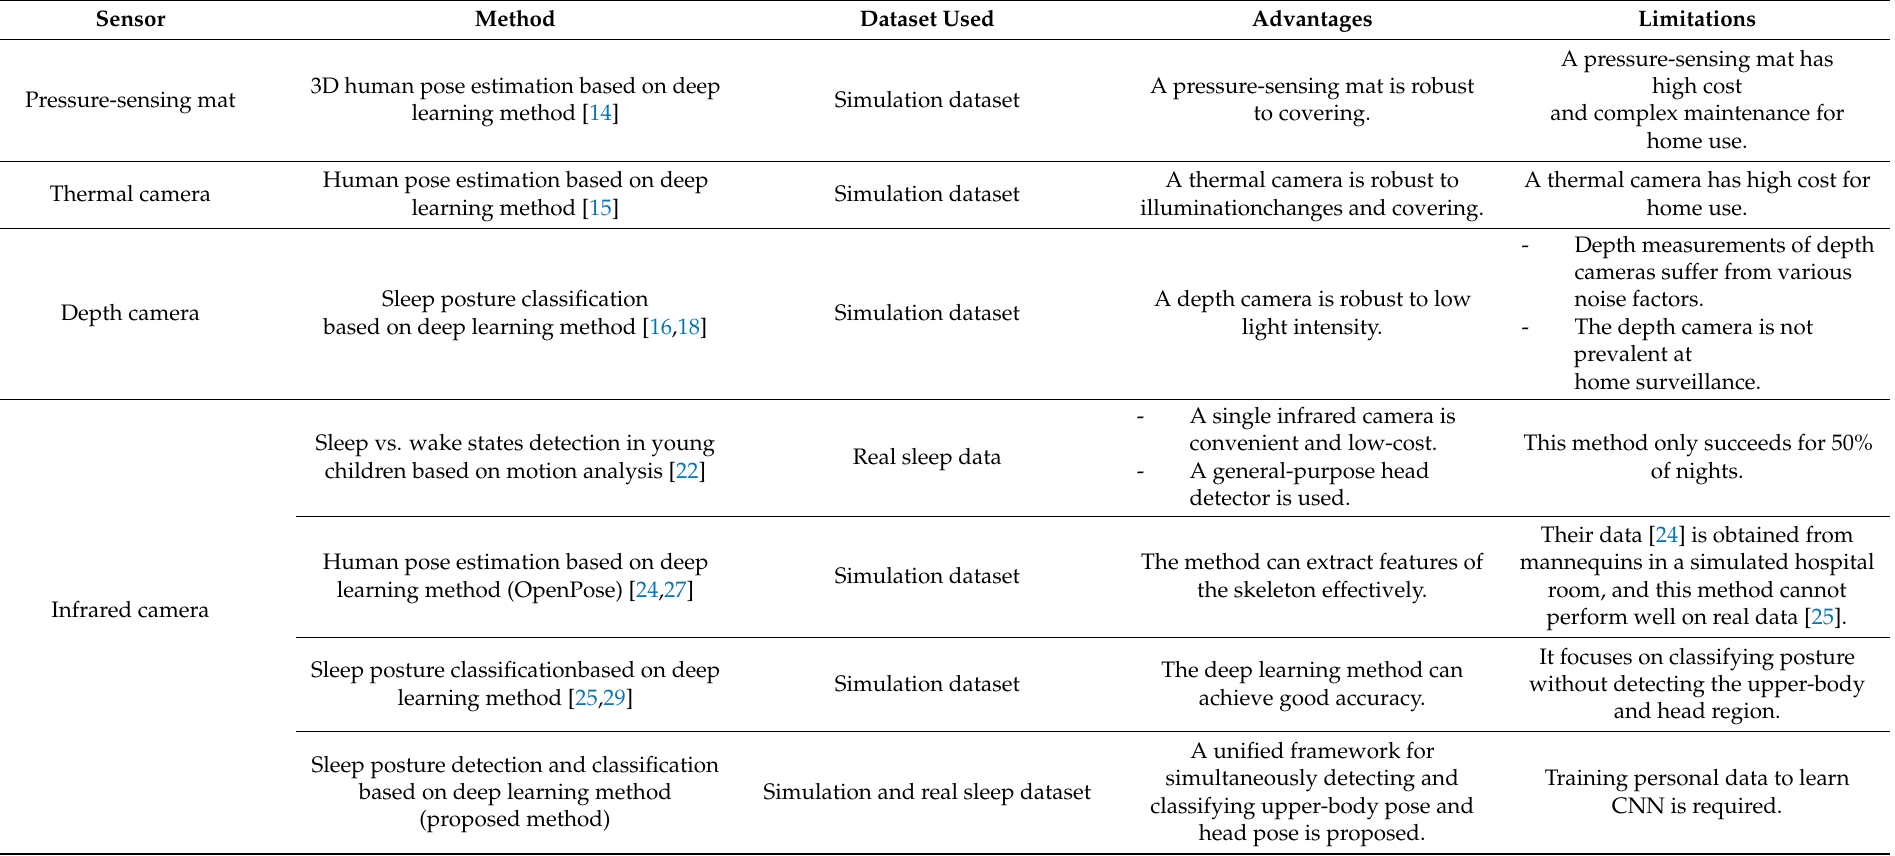
Table 1. Comparison of previous studies and the proposed method on sleep posture